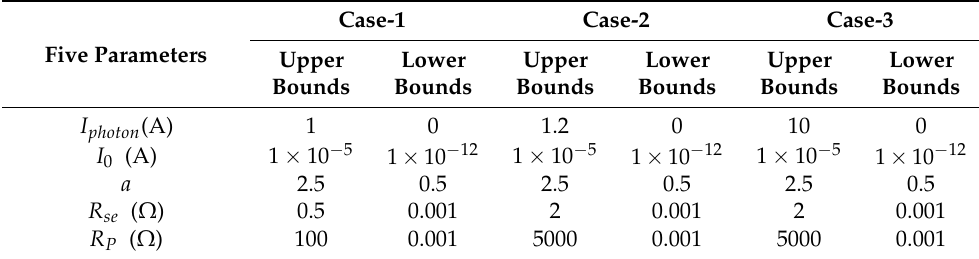
Table 1. Bounds of SDM for three different case